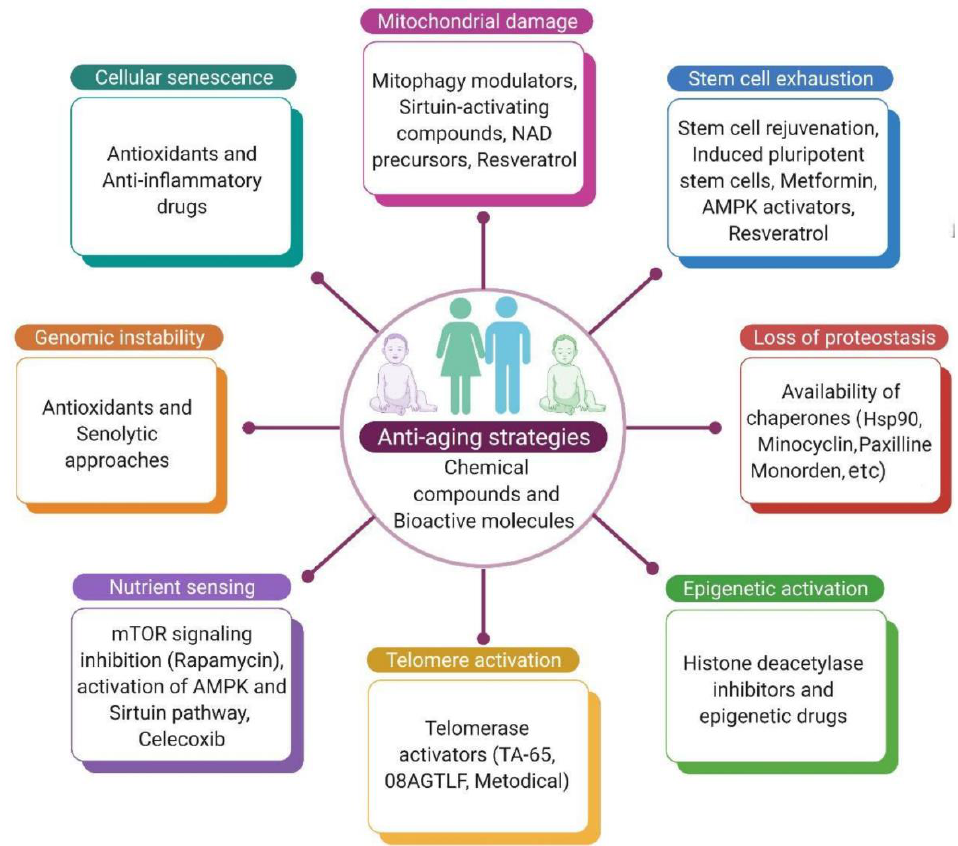
Figure 4. Antiaging strategies to counter aging that might extend the human lifespan based on the use of chemical compounds and bioactive molecules and their use in various approaches mentioned in the figure.